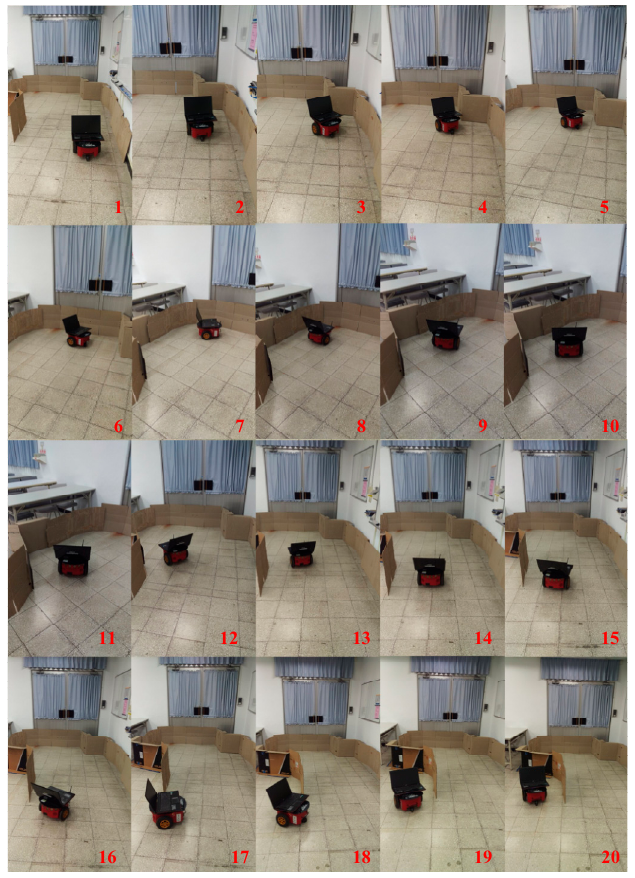
Figure 15. Wall-following control results of the PIONEER 3-DX in an actual environment using the FLC_R-IDS method.